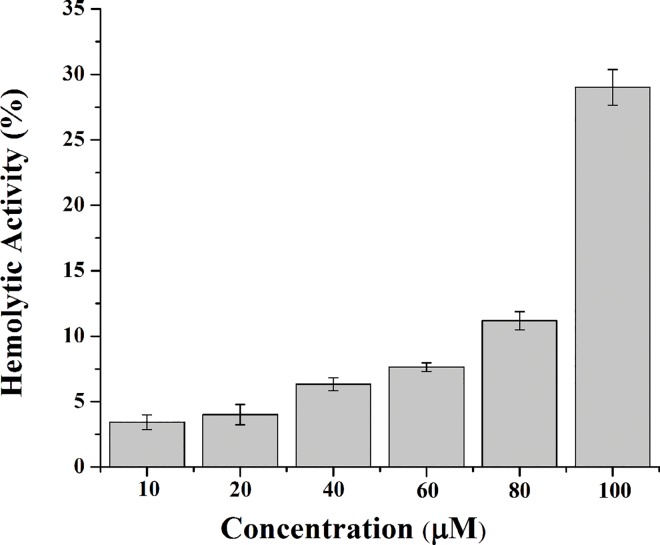
Hemolytic activity of HPRP-A2 against hRBCs.Data points present mean ± S.D. of three independent experiments. PBS and dH2O were used as negative and positive controls, respectively. Statistical analysis compared the HPRP-A2 treatment group with the positive control groups (*P < 0.005; **P <0.001).